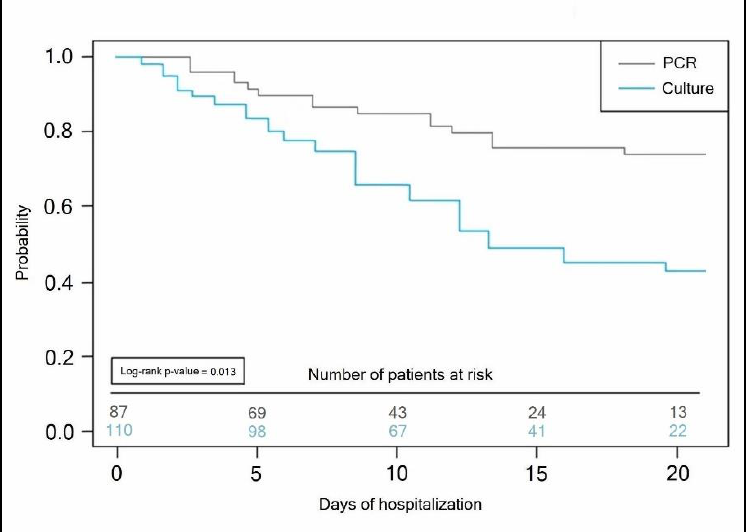
Figure 5. Kaplan–Meyer probability curve of hospitalization duration by the method of bacterial identification test employed in non-antibiotic takers. The risk factor analysis presented in Table 6 was adjusted for age, COVID-19 severity, and pulmonary disease. It was observed that over-the-counter use of antibiotics repre- sented a significant independent risk factor for a prolonged hospitalization (AOR = 1.21, p -value = 0.042). conventional bacterial culture (AOR = 1.17, p -value = 0.009), and a duration for